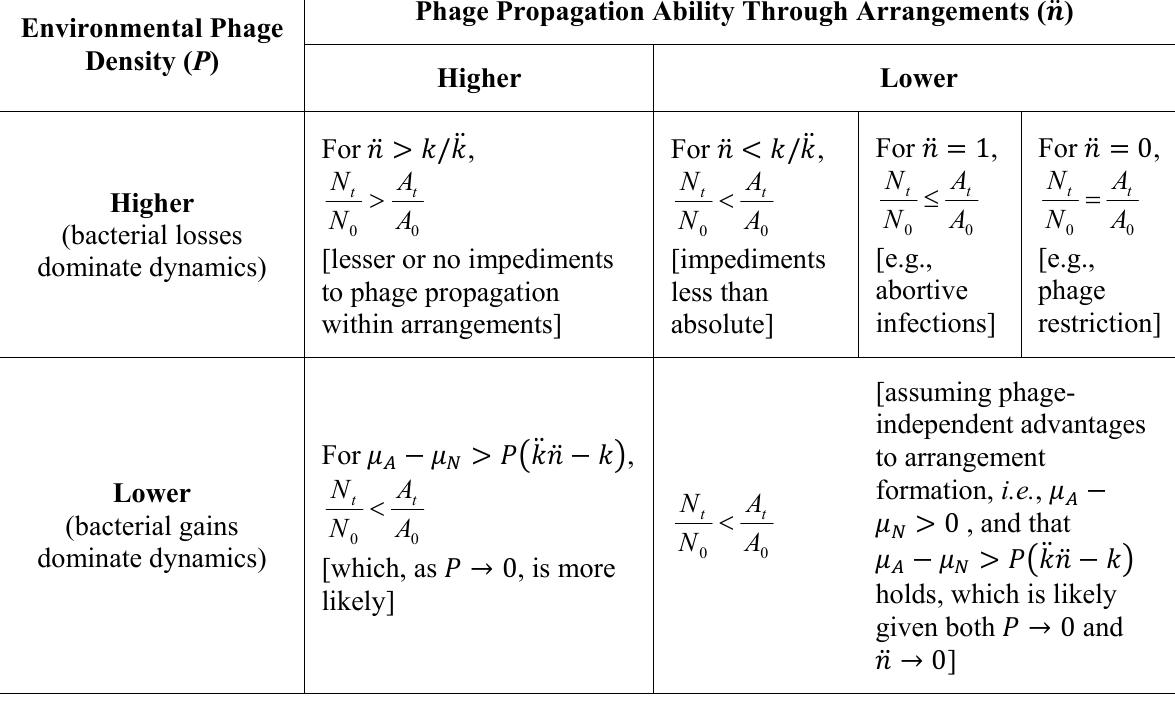
Table 1. Summary of predictions as a function of phage densities in environments and phage potential to acquire bacteria sequentially within bacterial arrangements (recall in // AANN  , implies greater success over interpreting the table that the inequality, 00 tt time in the face of phage-mediated predation for free bacteria versus bacteria found within // AANN  implies the opposite). Generally, (cid:1863)/(cid:1863)(cid:4663) (cid:3410) 1 . arrangements while 00 tt Calculations relevant to lower phage densities, as found in the bottom portion of the table, are not discussed until Section 2.3.3 and especially section